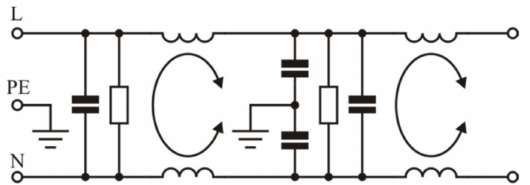
Figure 2. An optional input electromagnetic compatibility (EMC) filter can be connected at the output of the drive. We used the EMC input filter 10EMC3 F8148 1639 R 2 from CORCOM. (L-line, PE-protective earth,